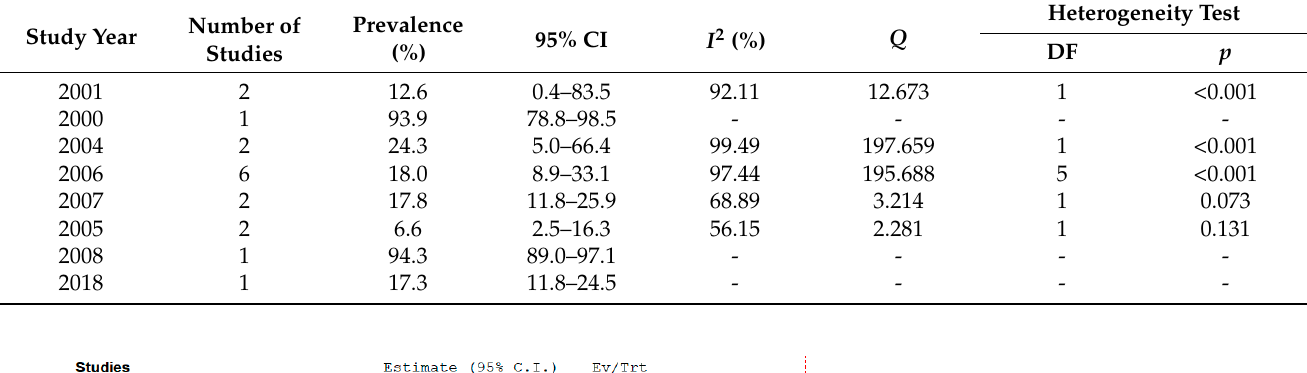
Table 2. Subgroup analysis for comparison of VRE in poultry in Malaysia across study year.